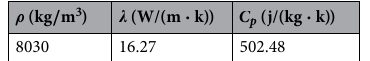
Table 2. Physical parameters of the substrate.